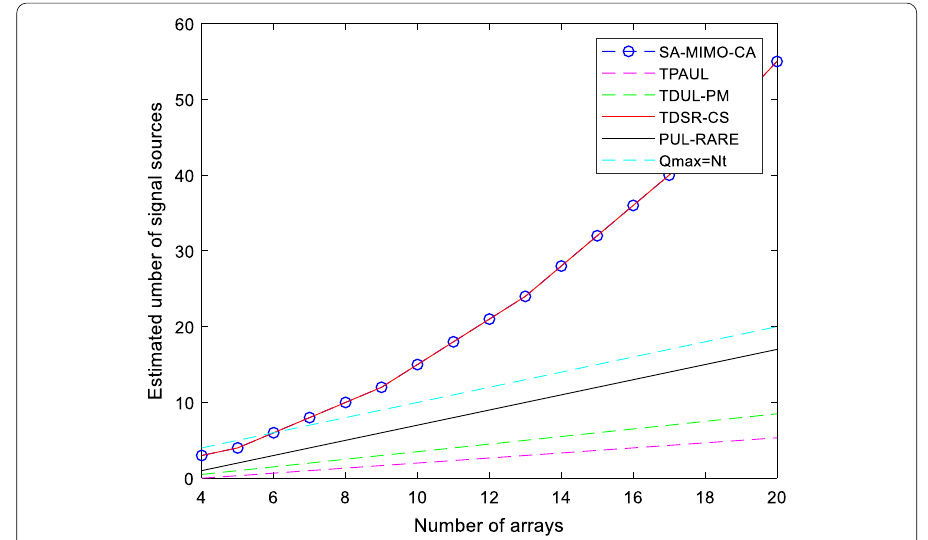
Fig. 6 The relationship between the number of arrays and the number of estimable